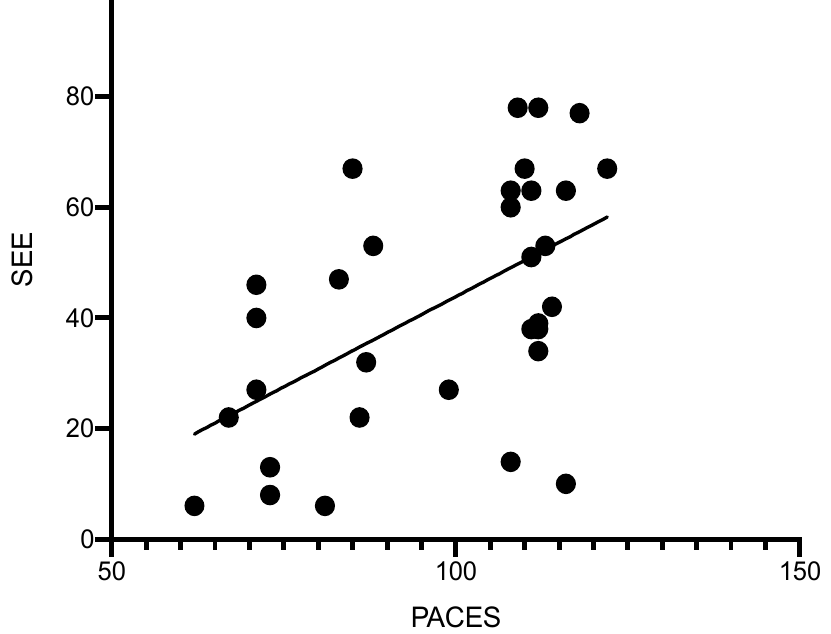
Figure 2. Relationship between SEE and PACE scores for both trials combined (MIIT + MICT). • represents each participant. (R 2 = 0.29, p = 0.001).